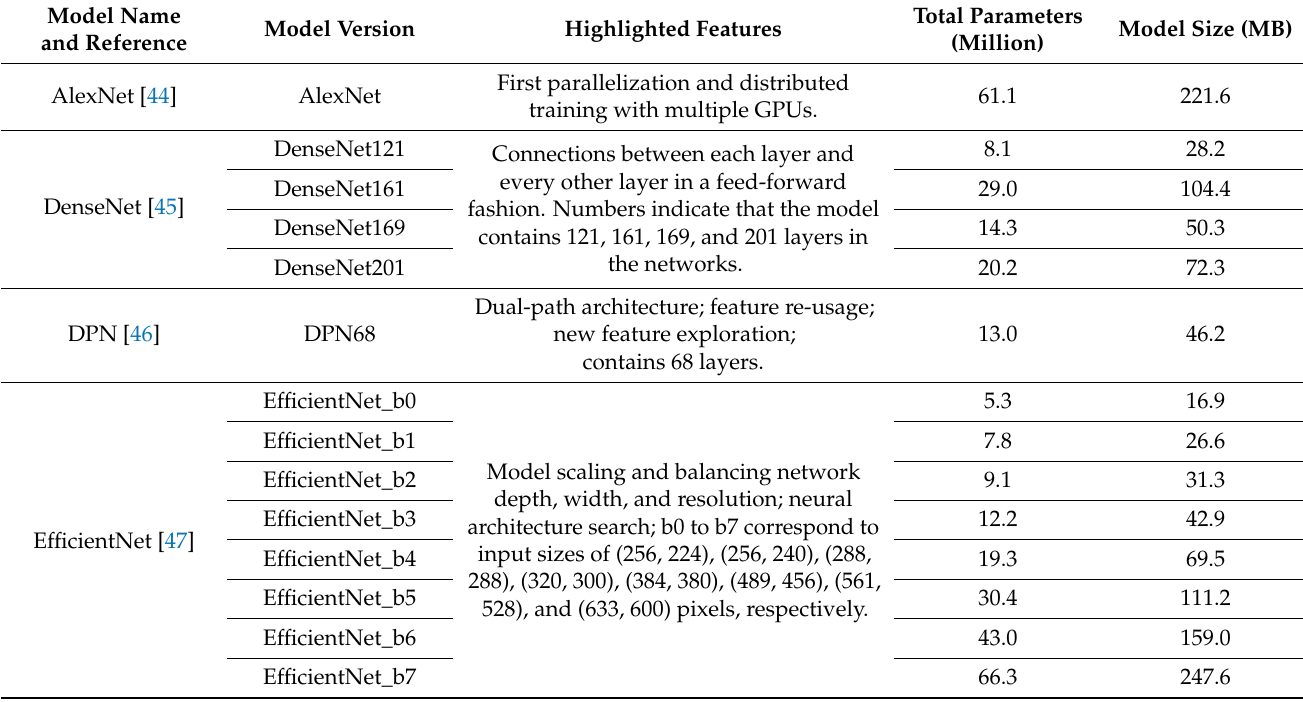
Table 2. Summary of deep learning image classification models evaluated in this study.